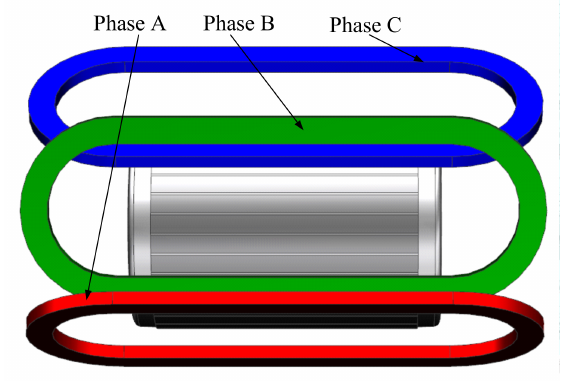
Figure 4. The 3D configuration of the windings and the rotor, winding bar section.